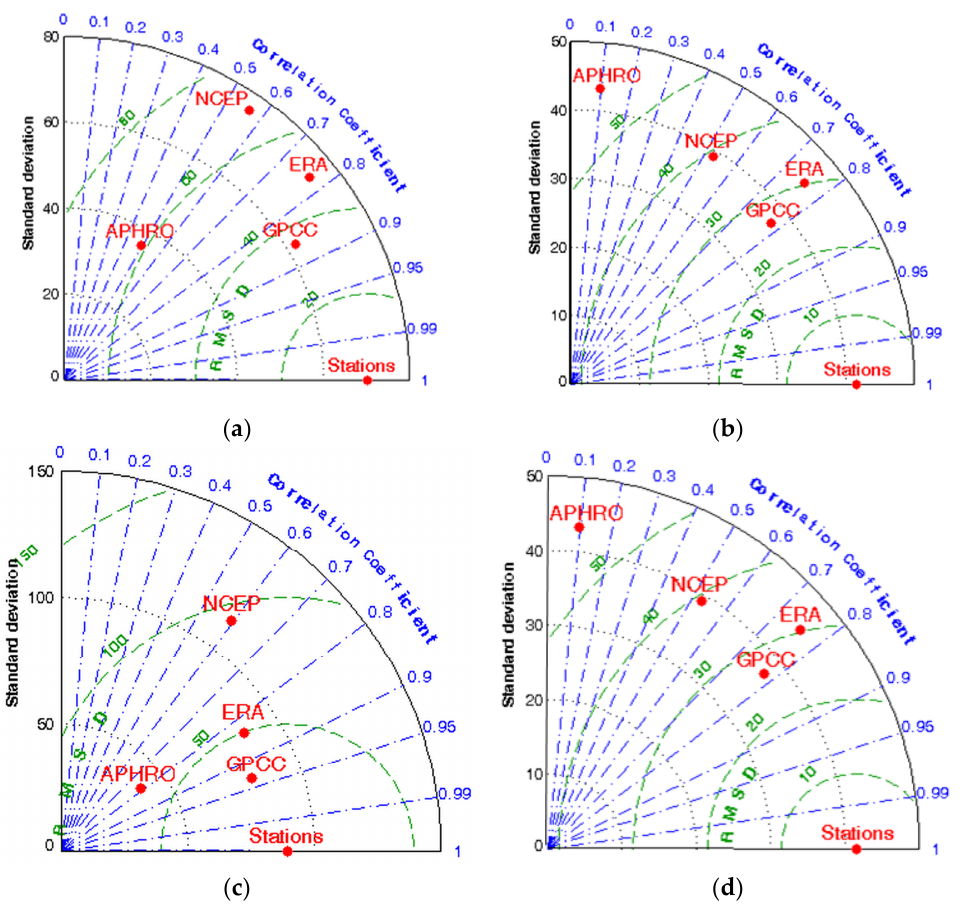
Figure 7. The comparison of the precipitation extremes (using the Taylor diagram) for the period of 1979 – 2018 (1979 – 2007 for the APHRO dataset) for the warm (left panel) and cold (right panel) seasons: ( a , b ) extremely low (5%) and ( c , d ) extremely high (95%). The cubic interpolation method is used.